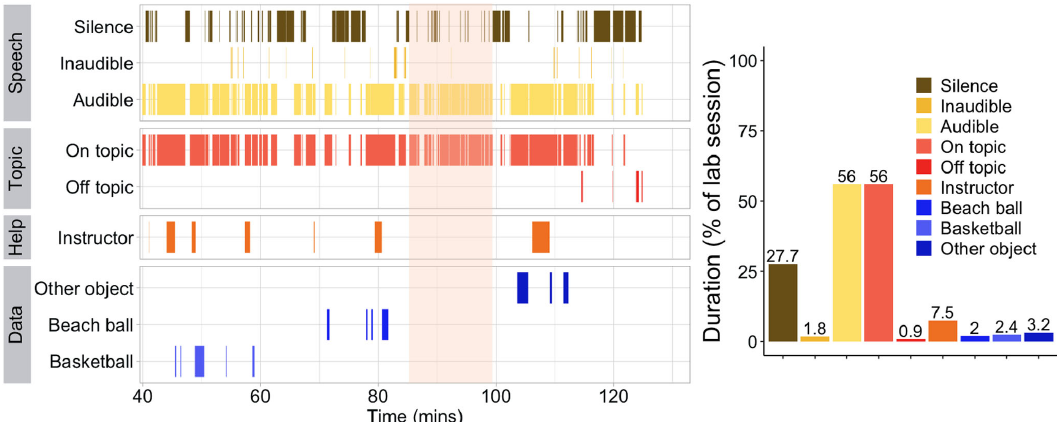
FIG. 13. Group D full timeline highlighting episode analyzed in Ref. [20] and durations of each behavior as a percentage of the video